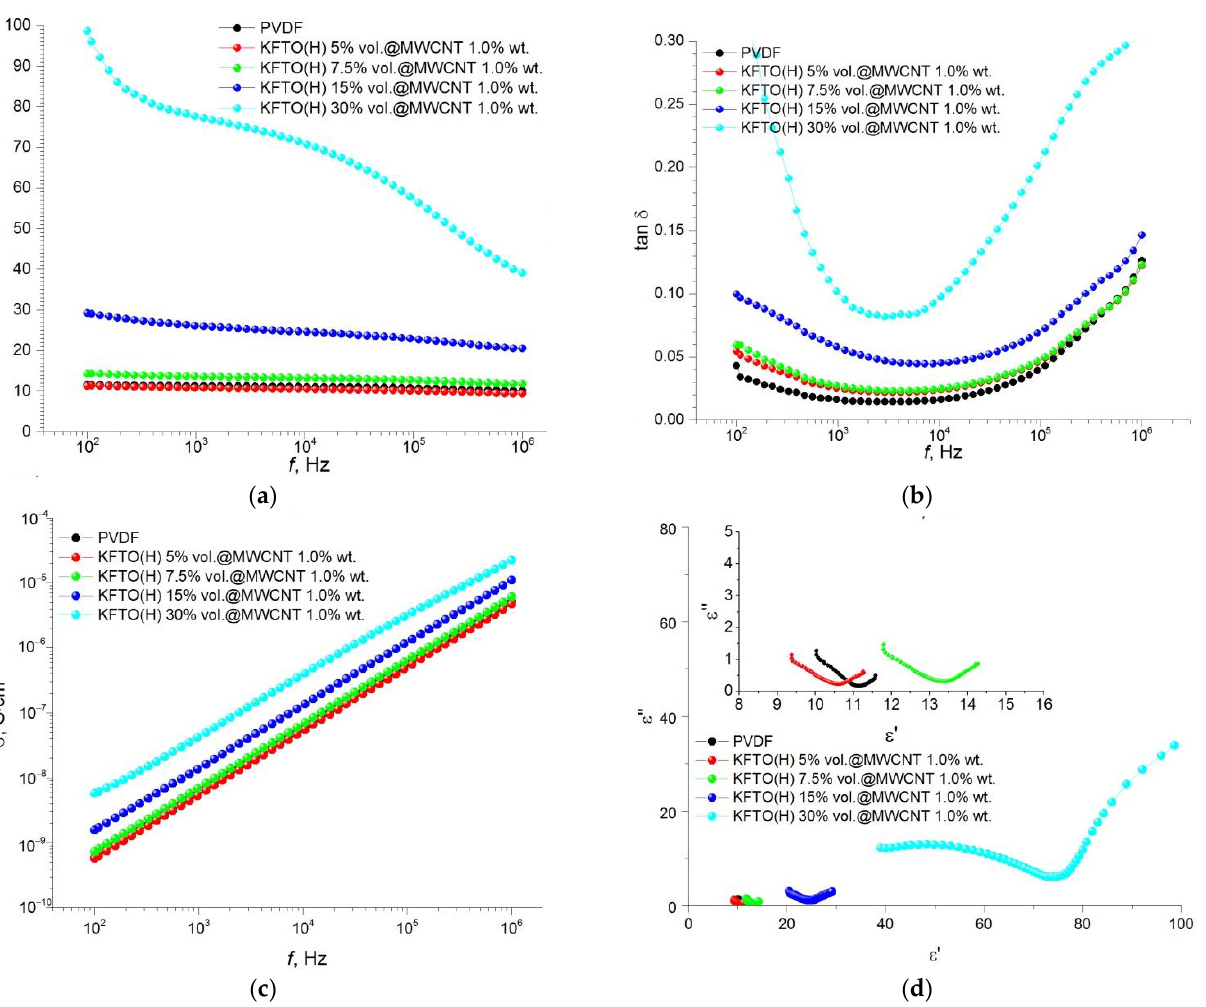
Figure 9. Frequency dependence of ( a ) permittivity, ( b ) dielectric loss tangent, ( c ) conductivity and ( d ) Cole –Cole plot (ε ′ –ε ″ ) for PVDF-based composites with different volume fractions of KFTO(H) with MWCNT additive of 1.0 wt.% (inset is the enlarged view of the basic figure).